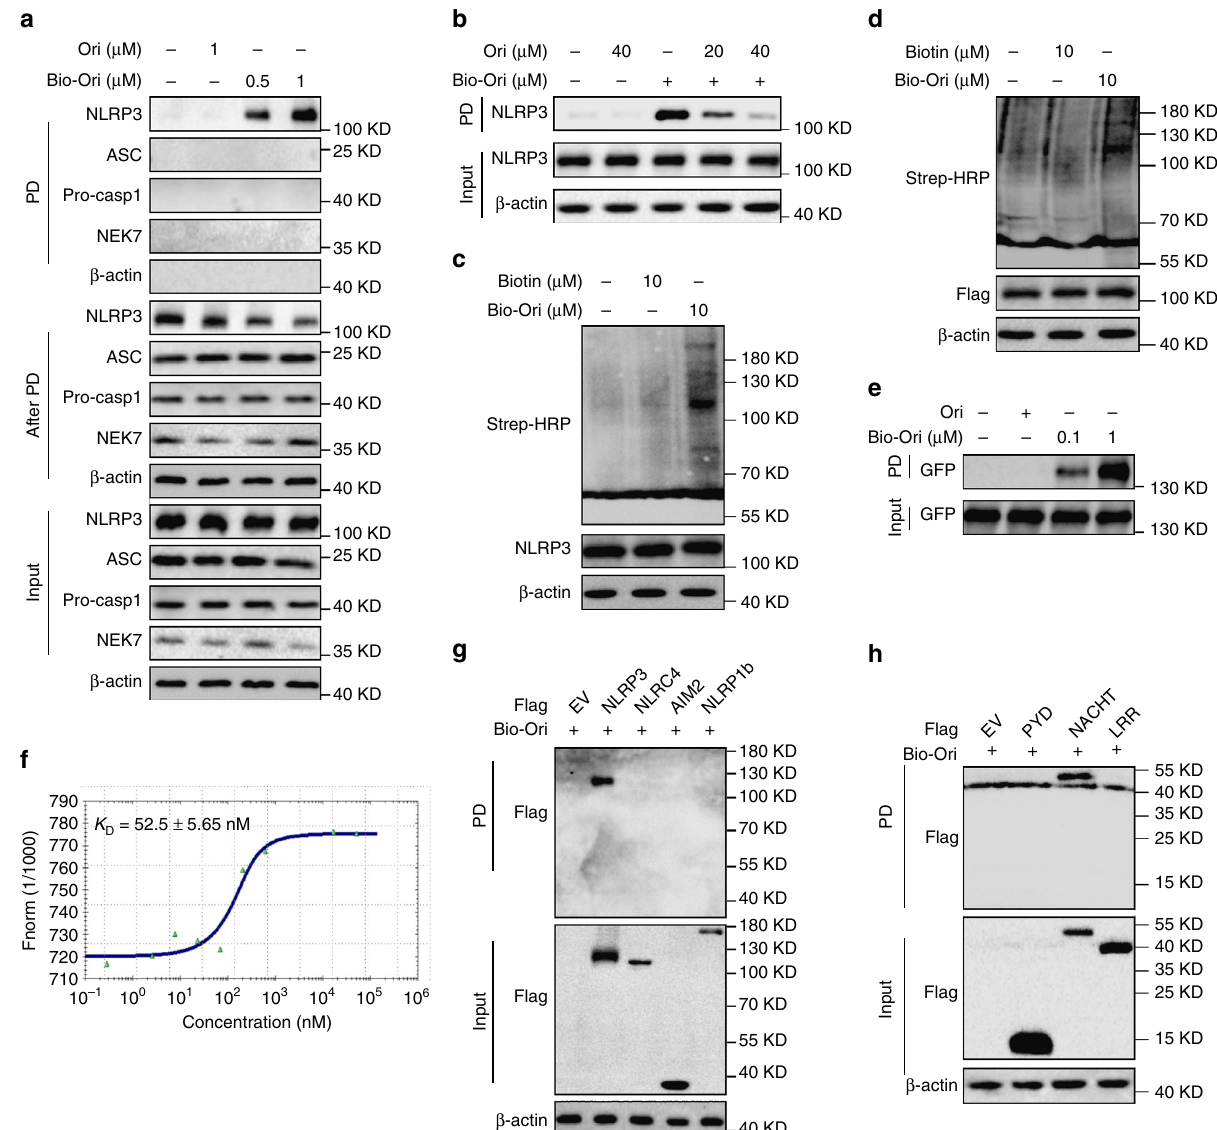
Fig. 3 Ori binds to NLRP3 NACHT domain. a Cell lysates of LPS-primed BMDMs were incubated with bio-Ori for 2 h, which were then pulled down using streptavidin beads. The total proteins (input), bound proteins (PD) and remained proteins (After PD) were immunoblotted as indicated. b Cell lysates of LPS-primed BMDMs were incubated with bio-Ori (1 μ M) and different concentrations of free Ori (20 μ M, 40 μ M), which were then pulled down using streptavidin beads. c Cell lysates of LPS-primed BMDMs incubated with bio-Ori or biotin and detected by Strep-HRP. d HEK-293T cell lysates overexpressing Flag-NLRP3 were incubated with bio-Ori or biotin and detected by Strep-HRP. e Puri fi ed human GFP-NLRP3 protein was incubated with indicated doses of bio-Ori (0.1 μ M, 1 μ M) and then pulled down using streptavidin beads. f MST assay for the af fi nity between Ori and puri fi ed GFP-NLRP3 protein. g – h Flag-tagged NLRP3, AIM2, NLRC4 or NLRP1 ( g ), NLRP3-LRR, NLPR3-NACHT or NLRP3-PYD ( h ) was expressed in HEK-293T cells. The HEK- 293T cell lysates were incubated with bio-Ori (1 μ M) and then were pulled down using streptavidin beads. Data are representative of two or three independent